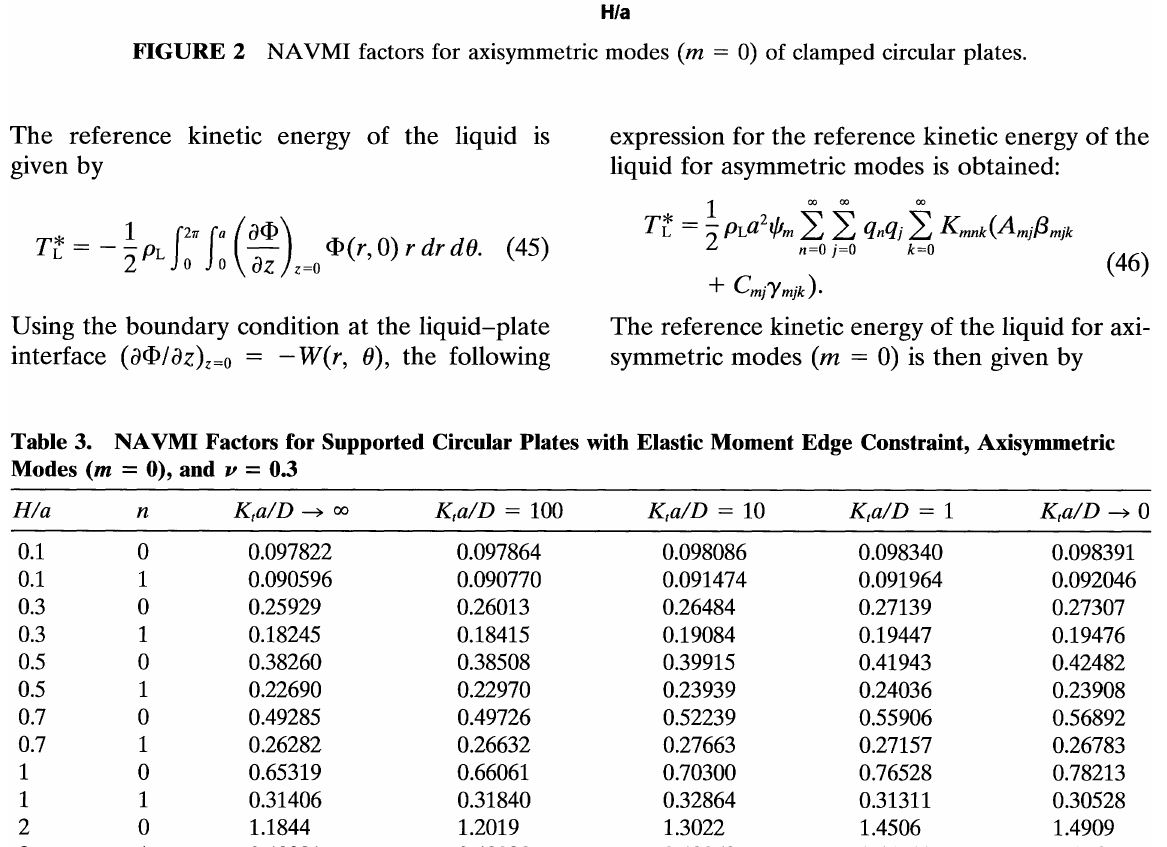
FIGURE 2 NA VMI factors for axisymmetric modes (m = 0) of clamped circular plates.